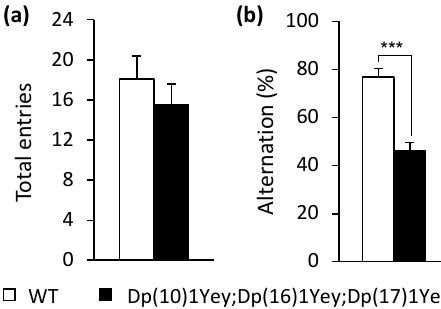
Figure 5. T-maze test: Dp(10)1Yey;Dp(16)1Yey;Dp(17)1Yey and the wild-type control mice were allowed to explore the arms of the T-maze for 10 min and each entry into each arm was recorded. ( a ) There was no difference in the average total entries between the two groups of mice ( p = 0.43). ( b ) Alternation rate was calculated with the times of correct entries over total times of entries. The alternation rate of Dp(10)1Yey;Dp(16)1Yey;Dp(17)1Yey mice was significantly less than that of the wild-type control mice. ***, p < 0.005.